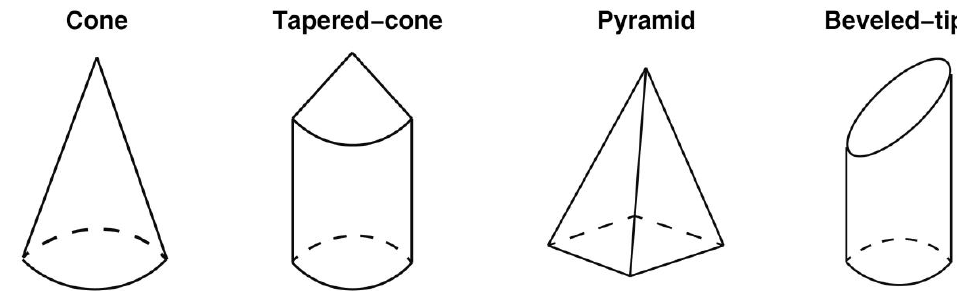
Figure 3. The different types and sizes of microneedle models [54] .